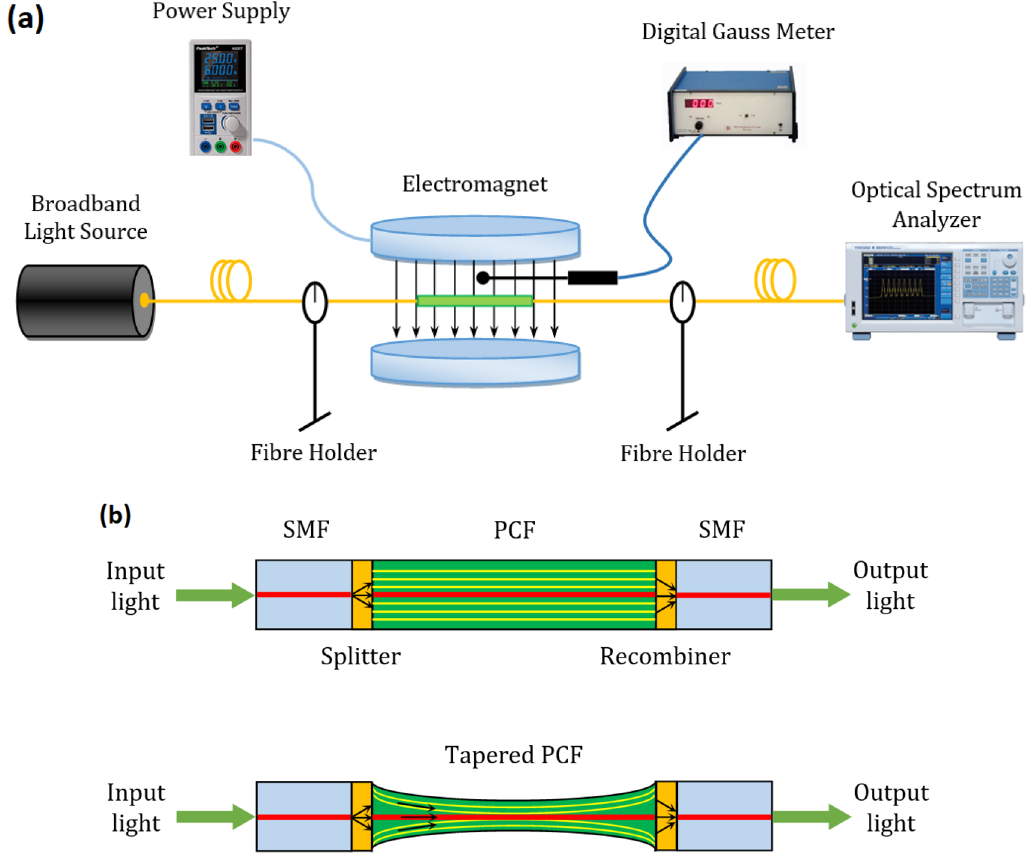
Figure 1. Schematic diagram of ( a ) the experimental setup for magnetic field sensing, ( b ) the in-line Mach–Zehnder interferometer in tapered